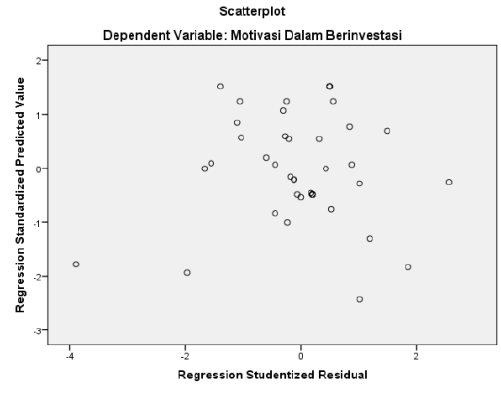
Figure 2 : Heteroscedasticity Test Results; Source: Processed data,